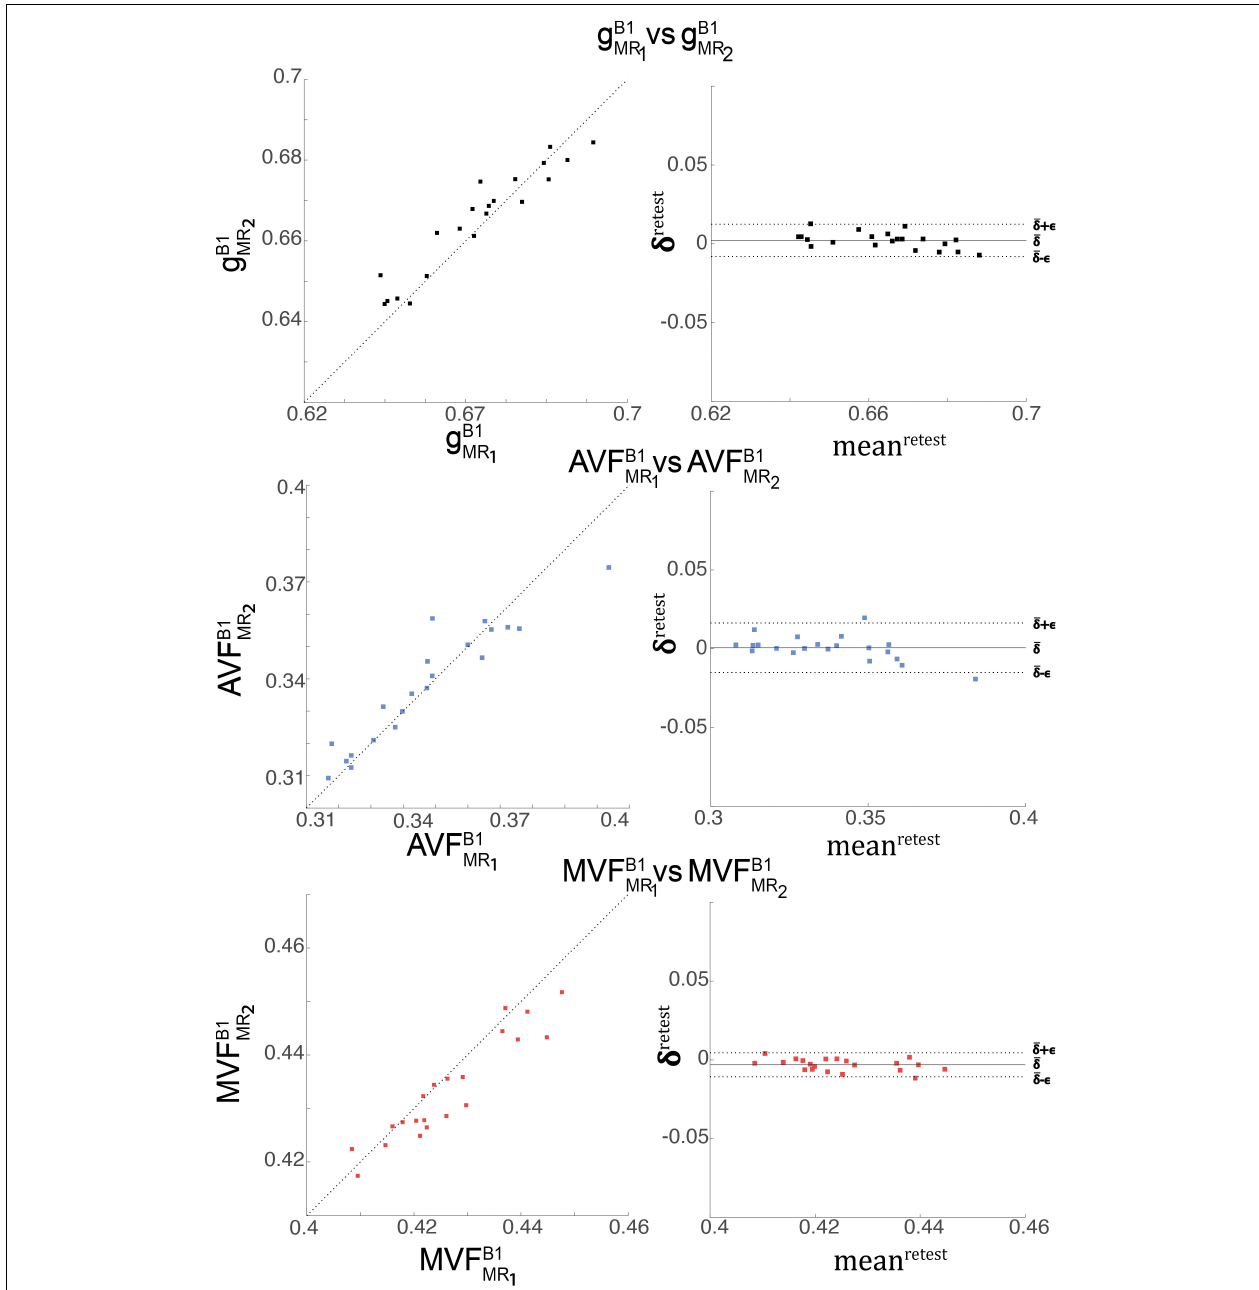
FIGURE 7 | Depicted are scatter and Bland-Altman plots of g B1 MR (first row), AVF B1 MR (second row), and MVF B1 MR (third row) from two session across 21 WM regions (denoted high-SNR ROIs, see Figure 4 ). The Bland-Altman plot illustrates the differences between values obtained from the two sessions (e.g., g B1 MR (cid:1) δ retest ) = (cid:0) g B1 − ( g B1 ) against their mean (e.g., mean retest i = MR1 MR2 i i i group-averaged value in a single ROI. The bold black line represents the bias ( δ retest = 1 21 P 21 i = 1 δ retest i ), while the dashed line shows error ( (cid:101) retest = 1 . 96 · SD ( δ retest i ) ) between the two